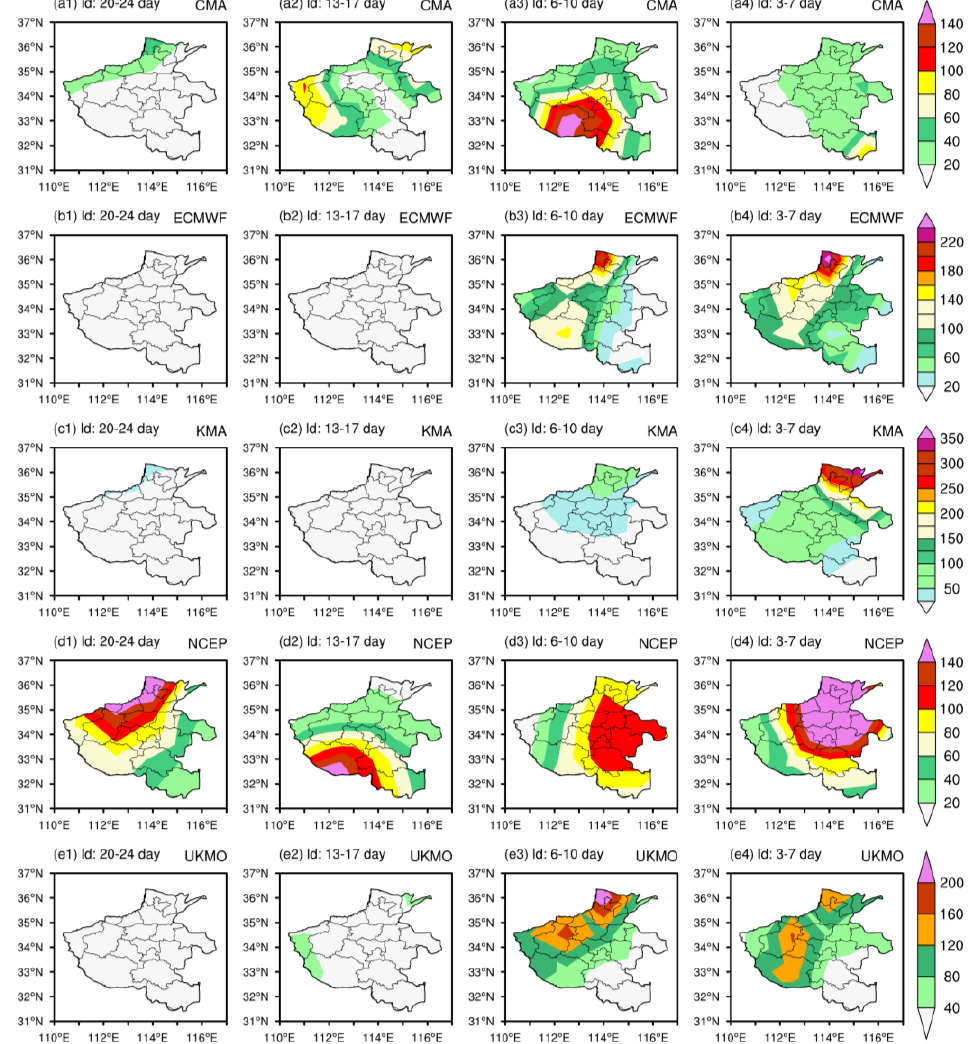
Figure 6. Spatial distribution of accumulated rainfall (unit: mm) during 18 – 22 July in Henan Province predicted by the five models 20 days, 13 days, 6 days, and 3 days in advance, respectively: ( a1 – a4 ) CMA model; ( b1 – b4 ) ECMWF model; ( c1 – c4 ) KMA model; ( d1 – d4 ) NCEP model; ( e1 – e4 ) UKMO model. Table 3. TCs of cumulative rainfall prediction during 18 – 22 July in Henan.